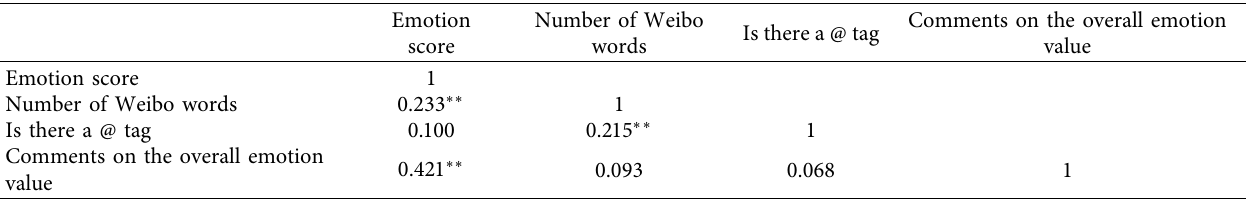
Table 7: Analysis of the correlations between Weibo prosocial emotion and the overall emotion value of